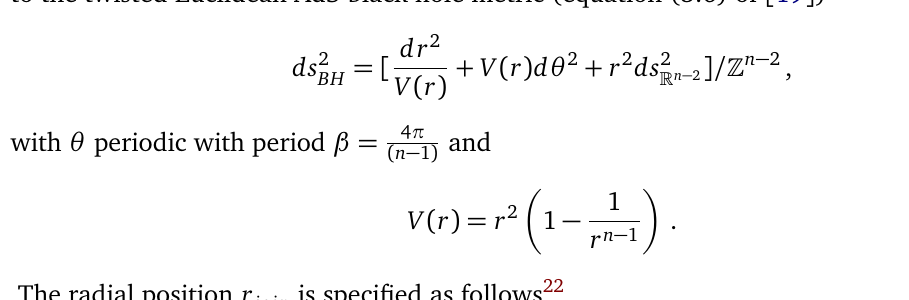
Figure 13: A long simple closed geodesic σ (blue) in the cusp cross sectional T n − 1 . to the twisted Euclidean AdS black hole metric (equation (3.6) of [ 19 ] )